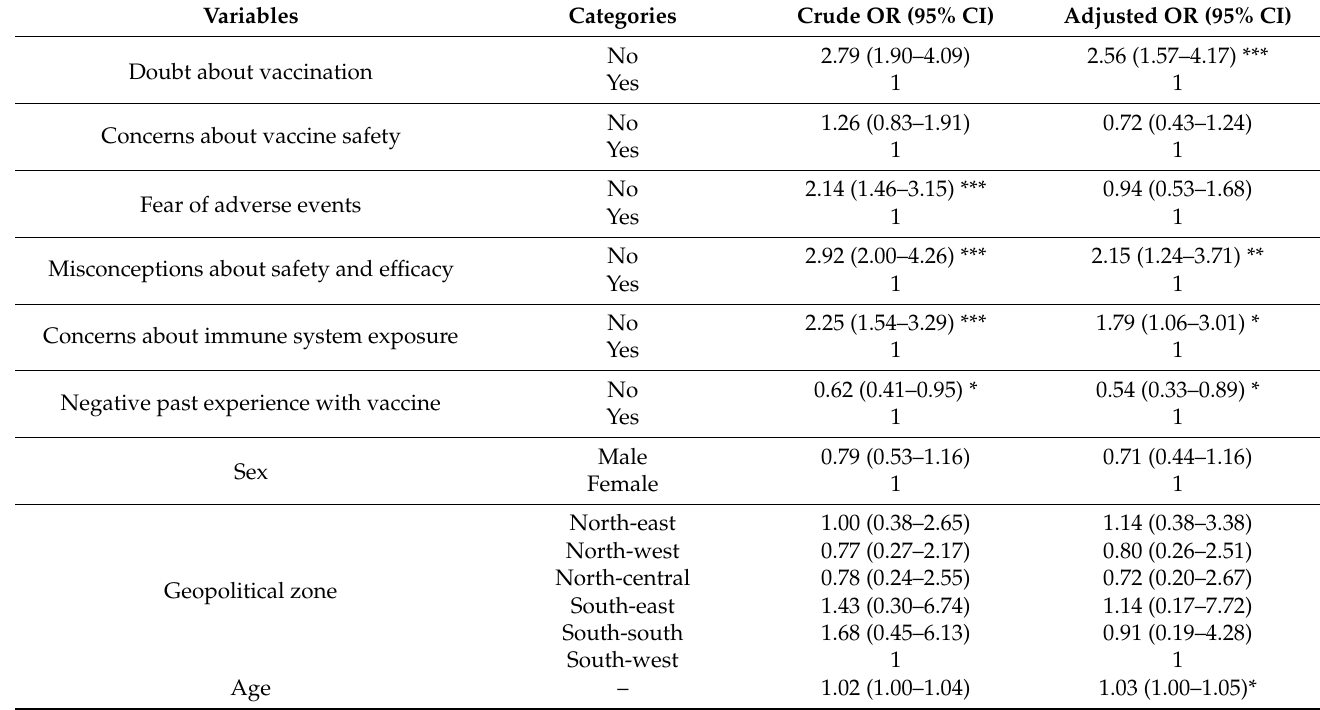
Table 3. Association between reasons for vaccine refusal and COVID-19 vaccination uptake (N =